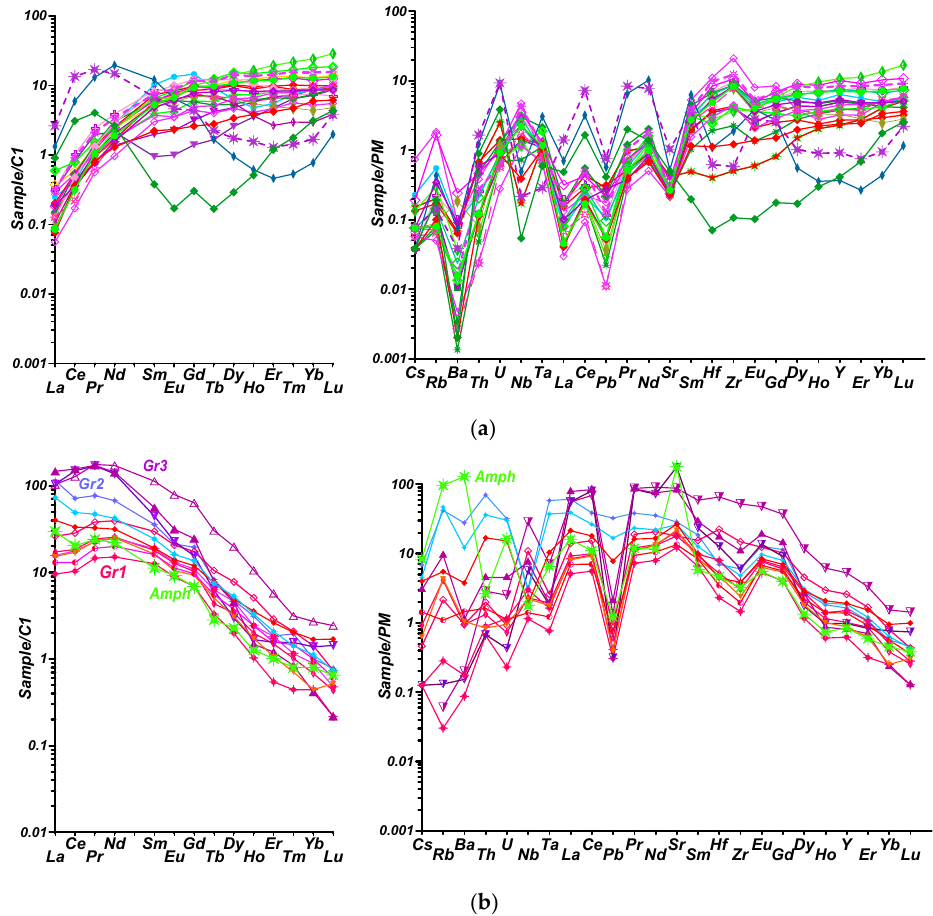
Figure 12. REE and spider-diagrams ( a ) for the Cr garnets, ( b ) for the Cpx from concentrates of Novinka pipe. Normalization to chondrite C1 [17] and primitive mantle [32].